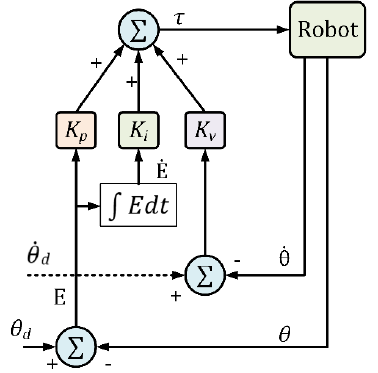
Figure 10. PID control schematic.